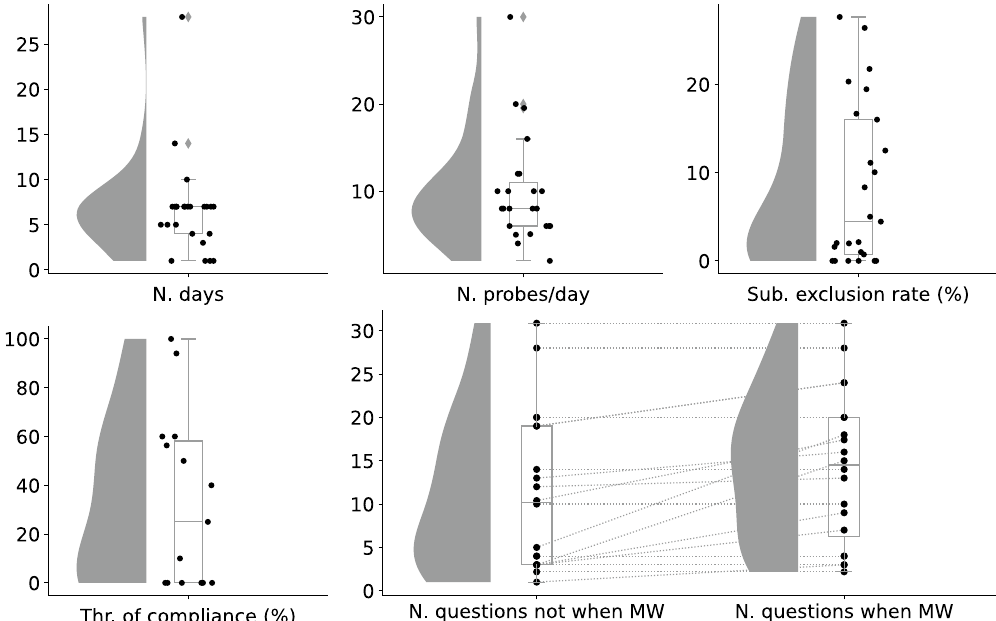
Figure 2. The distribution of experimental parameters of reviewed articles. N. days Number of days (Experiment duration), N. probes/day Expected number of probes per day, Sub. exclusion rate (%) Rate of excluded subjects to recruited subjects, Thr. of compliance (%) Threshold of compliance rate (only if authors used compliance rate as a criterion of subject exclusion), N. questions not when MW Expected number of questions if MW does not exist, N. questions when MW Expected number of questions if MW exists.